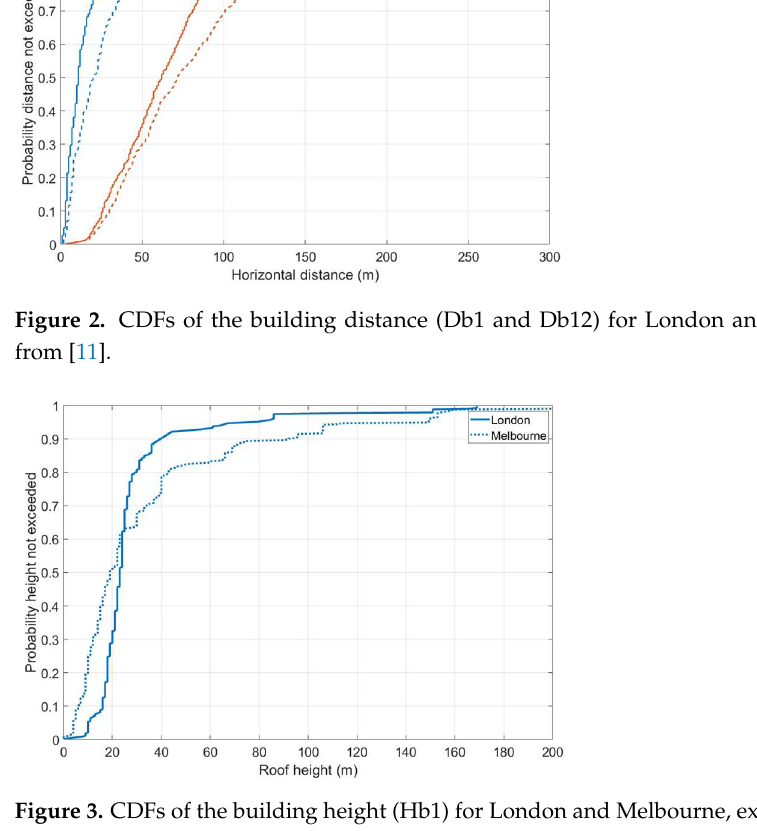
Figure 2. CDFs of the building distance (Db1 and Db12) for London and Melbourne, extracted from [11].